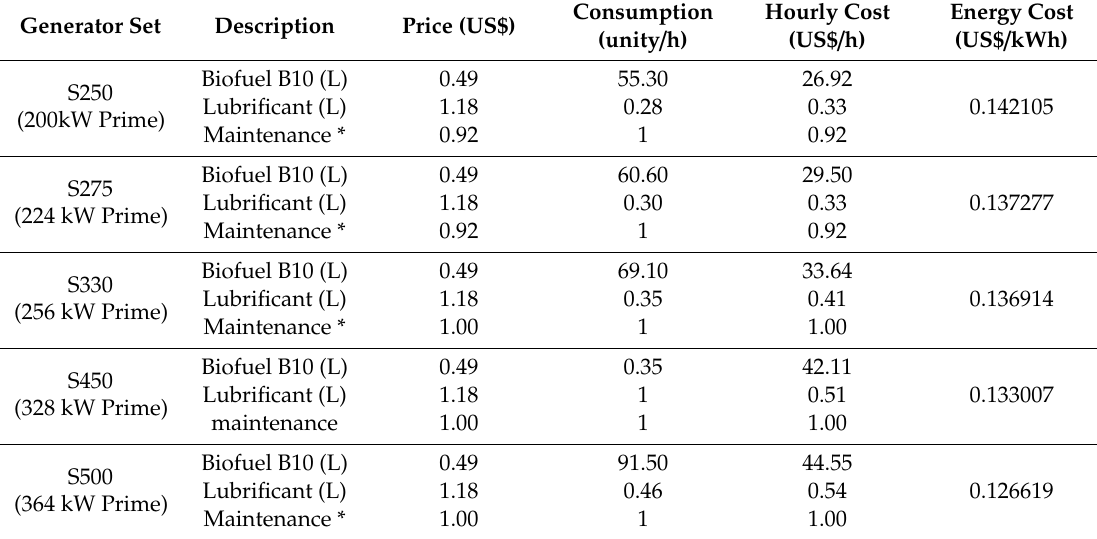
Table 5. Characteristics of the main generator and their